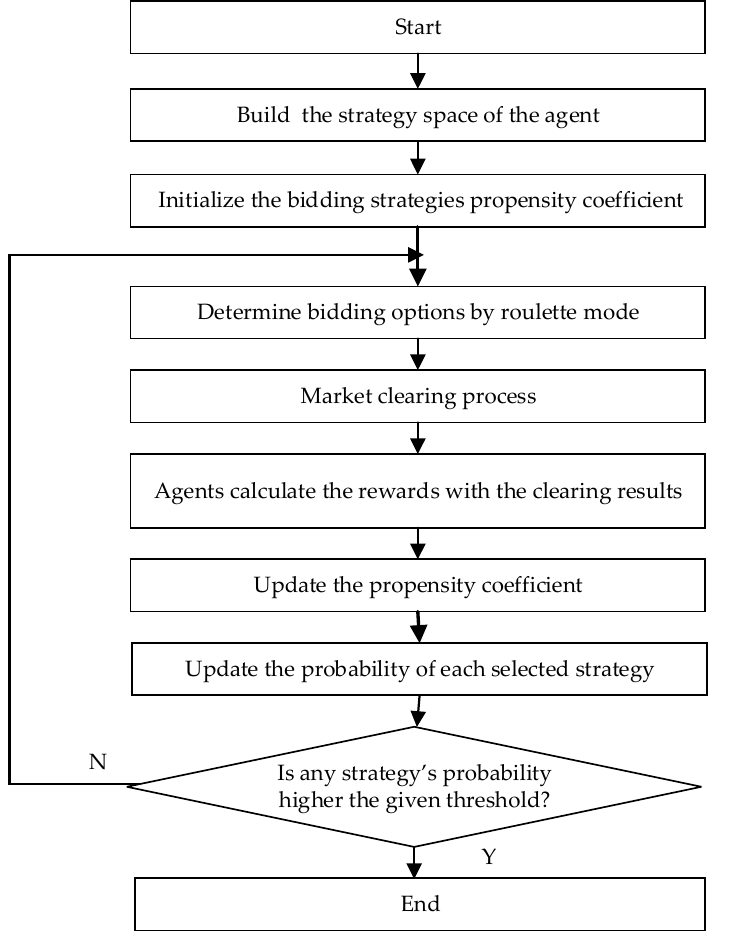
Figure 6. Simulation flow chart.